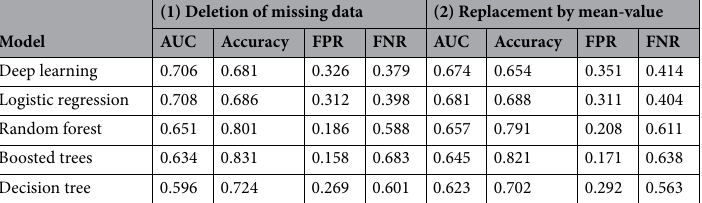
Table 3. The performance of deep learning and machine leaning models. AUC area under the curve, FPR false positive rate, FNR false negative rate.